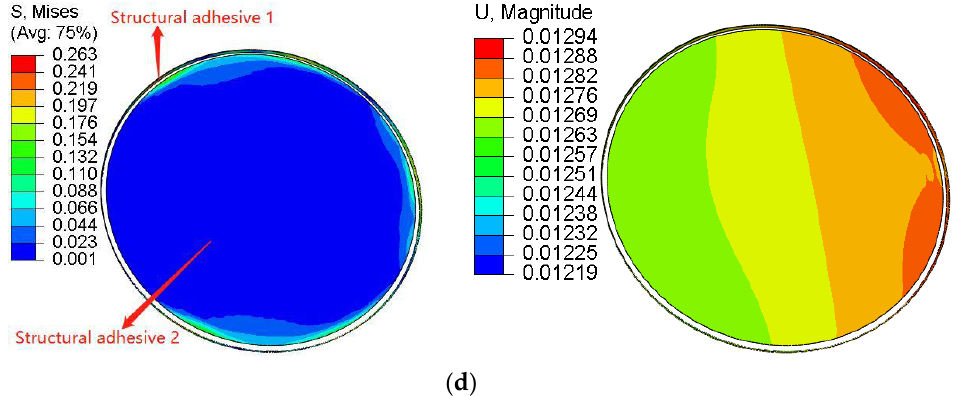
Figure 7. Stress and strain cloud diagram of the novel GRM parts: ( a ) Overall stress and strain cloud diagram of the novel GRM. ( b ) Stress and strain cloud diagram of the beryllium sheet. ( c ) Stress and strain cloud diagram of the quartz. ( d ) Stress and strain cloud diagram of the structural adhesive.